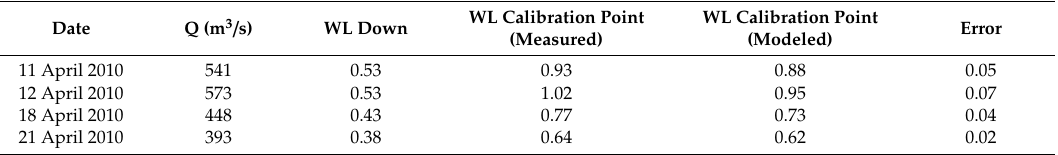
Table 5. The results of the validations runs of the hydrodynamic model. WL stands for water level and the unit is meters. “Error” means the modeling error at the calibration